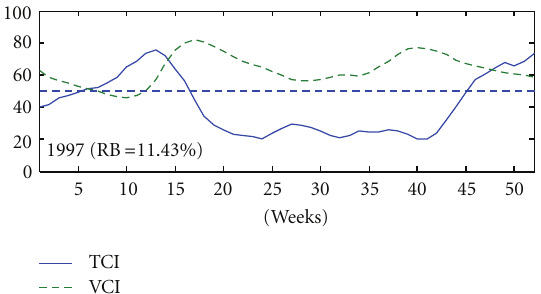
Figure 7: Dynamics of TCI during the years of RB exceeding the evaluation